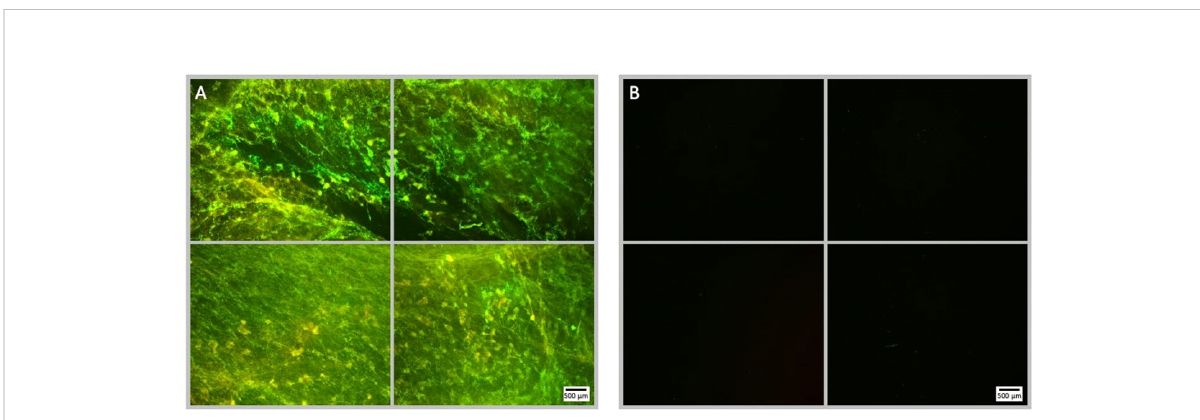
FIGURE 8 Fluorescence microscopy images of NOMB only treated P. aeruginosa bio fi lm, stained with Syto9 (green) and PI (red). Panel (A) images depict the pre-treatment morphology of the bio fi lm over a 1 cm 2 area. Panel (B) images show the changes in attached biomass after ultrasound stimulation of a NOMB suspension without antibiotic; 45 Vpp was applied to the transducer to reach an acoustic pressure of 0.5 MPa at the target site for 40 s, with a driving frequency of 0.9 MHz, duty cycle of 20% and a 500 Hz